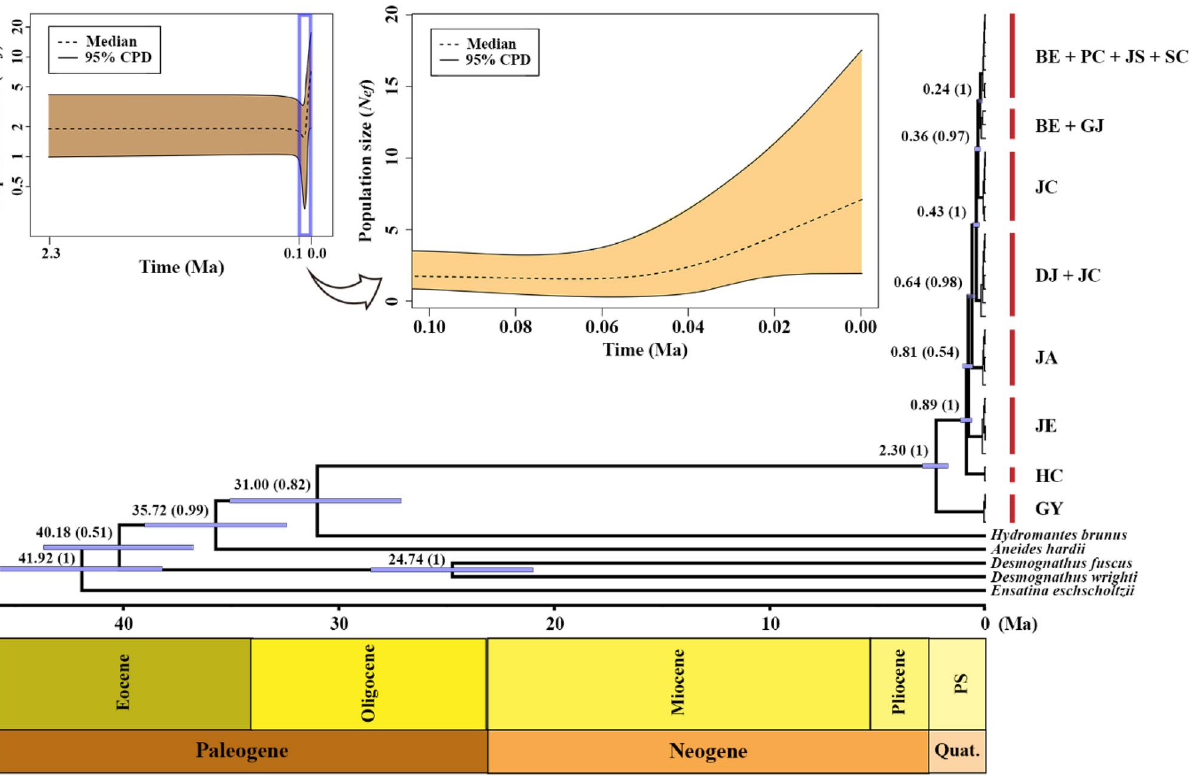
Figure 3. Time-calibrated Bayesian tree reconstructed using BEAST based on the concatenated sequences of cytochrome c oxidase I and cytochrome b , given with a geological time scale chart under the time scale bar (abbreviations: PS: Pleistocene, Quat.: Quaternary). At each major node, median divergence date is represented in Ma (million years ago) and the posterior probability of the date is indicated in brackets. The insets show Bayesian skyline plots of 0–2.3 Ma range (top left) and the 0–0.1 Ma range is magnified (top right). X and Y axes represent time (Ma) and log-scale effective population size ( Nfe ), respectively. Population codes follow Table 1.